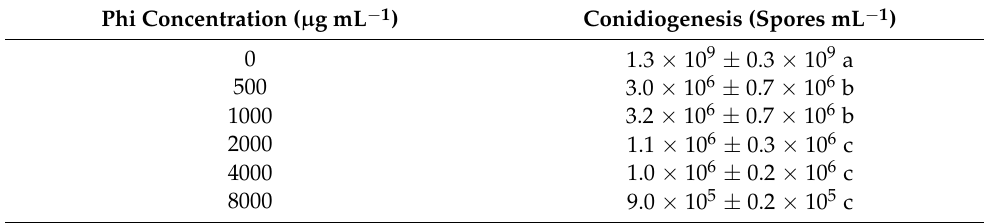
Means ± SD with different letters are statistically different (Fisher’s test; α =